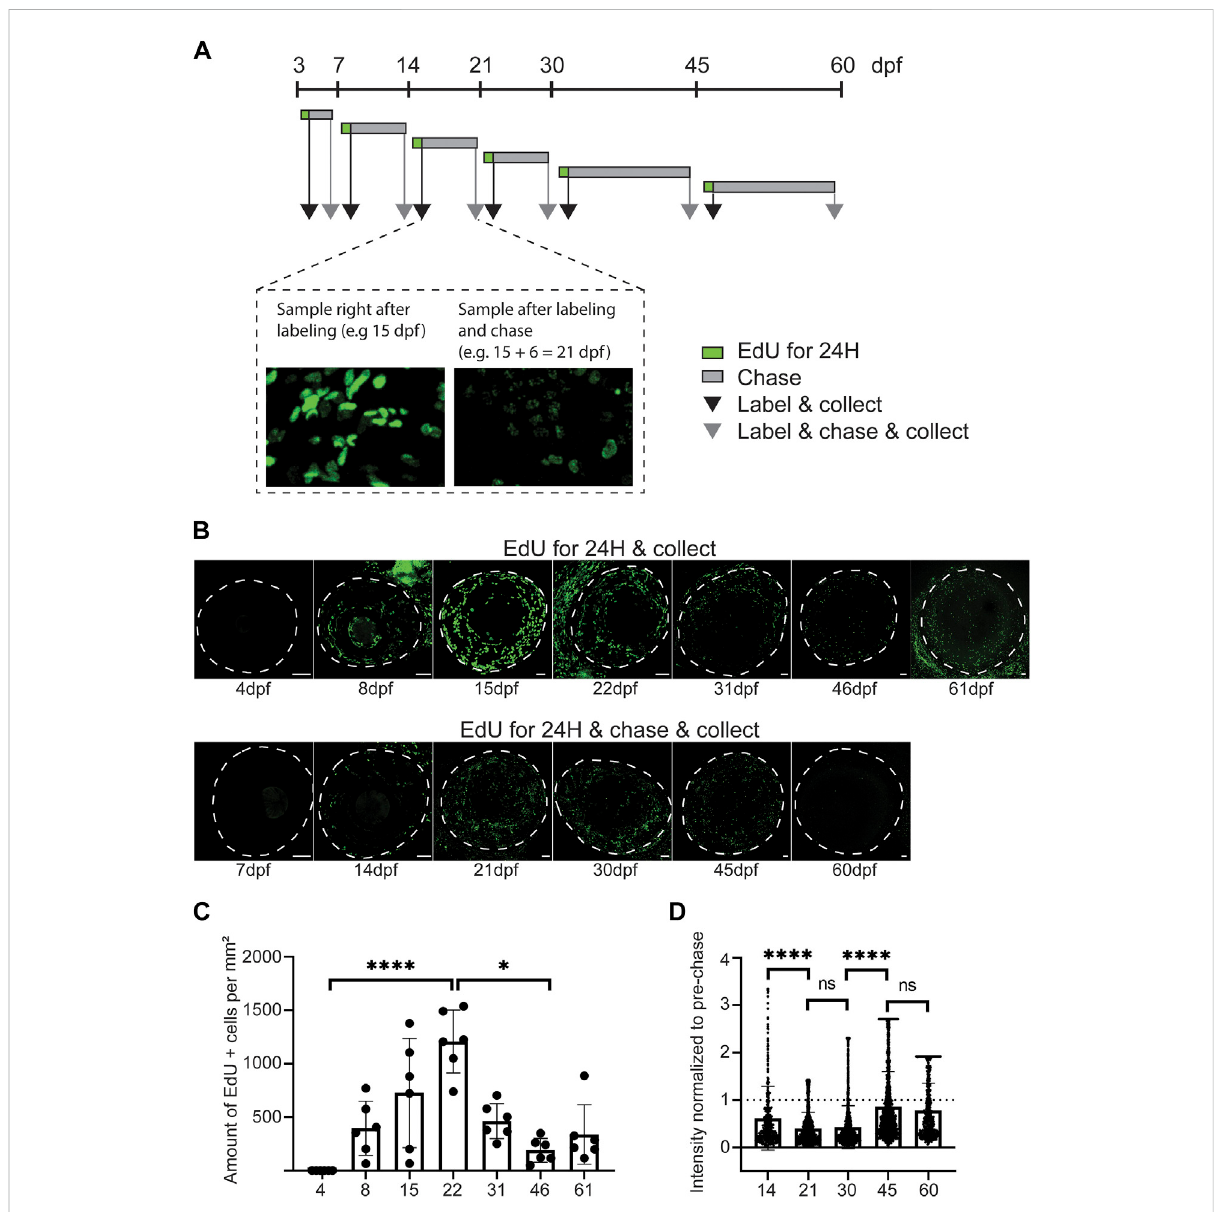
Proliferative activity on zebra fi sh cornea, as shown by EdU incorporation. (A) EdU was administered to the fi sh for 24 h at indicated ages. Samples were collected either right after labeling (black arrow), or after chase (grey arrow). (B) Representative images of whole mount samples on intacteyes.Dashedlineindicatestheeyeborder.Scalebars:50 µm. (C) Quanti fi cationsoftheproliferativeactivityfrom3to61dpf. (C) TheEdU+cell amounts on the cornea right after labeling in samples collected at indicated ages. The bars show mean ± SD (n = 6, Kruskal-Wallis test with Dunn ’ s multiple comparisons test). (D) The mean signal intensity decrease of EdU + cells in samples collected after chase, relative to samples collected before chase. Each cell ’ s value was normalized to the mean pre-chase value of the labeling group in question. Cells from 3 eyes per group were pooled for analysis. The bars show mean ± SD (n = 383 for 14dpf, 1325 for 21dpf, 2,255 for 30dpf, 1682 for 45dpf, and 570 for 60dpf, Kruskal- Wallis test with Dunn ’ s multiple comparisons